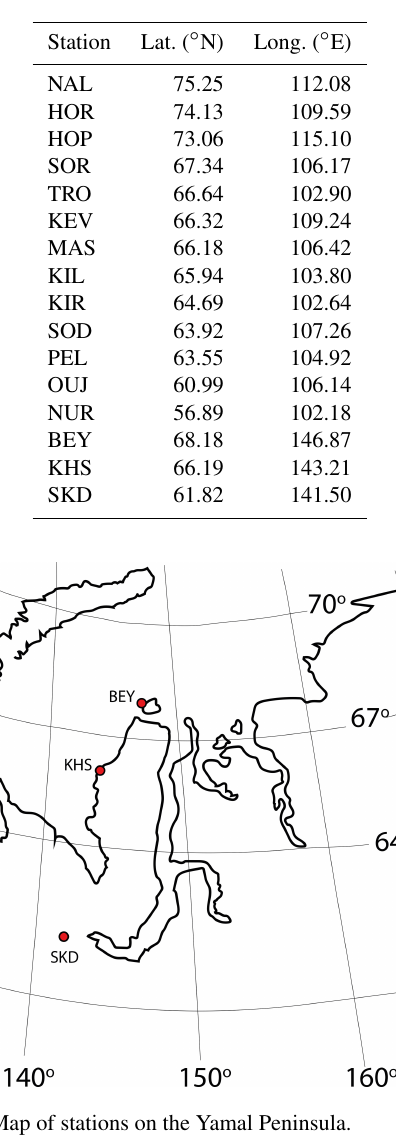
latitudinal range spans ± 4 ◦ from the southernmost and north- ernmost stations (for the models with many elementary cur- rents). The input magnetic field disturbance is forced to be zero at the edges of this range in order to avoid nonphysical solutions. Ground magnetic disturbances are produced by the ionospheric current (electrojet) and the corresponding induc- tion current inside the Earth. The model latitudinal profile of ionospheric current is reconstructed using the north–south X and the vertical Z magnetic components that are measured at a set of ground observatories (magnetic stations). Currently, we ignore the Y component of the magnetic